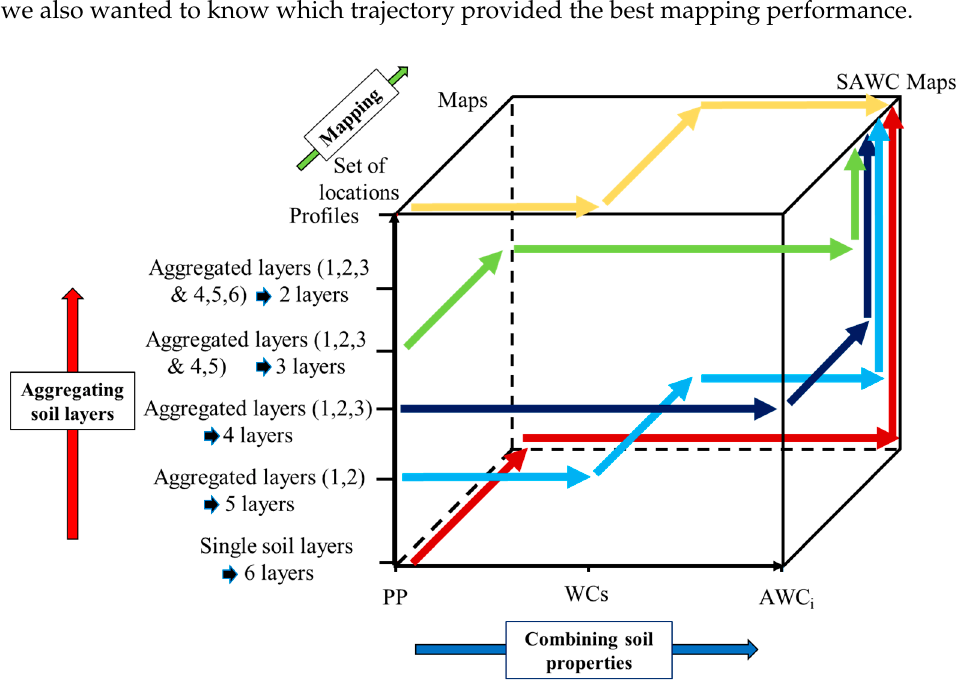
Figure 2. Concept of soil available water capacity (SAWC) digital soil mapping with a few examples of inference trajectories .